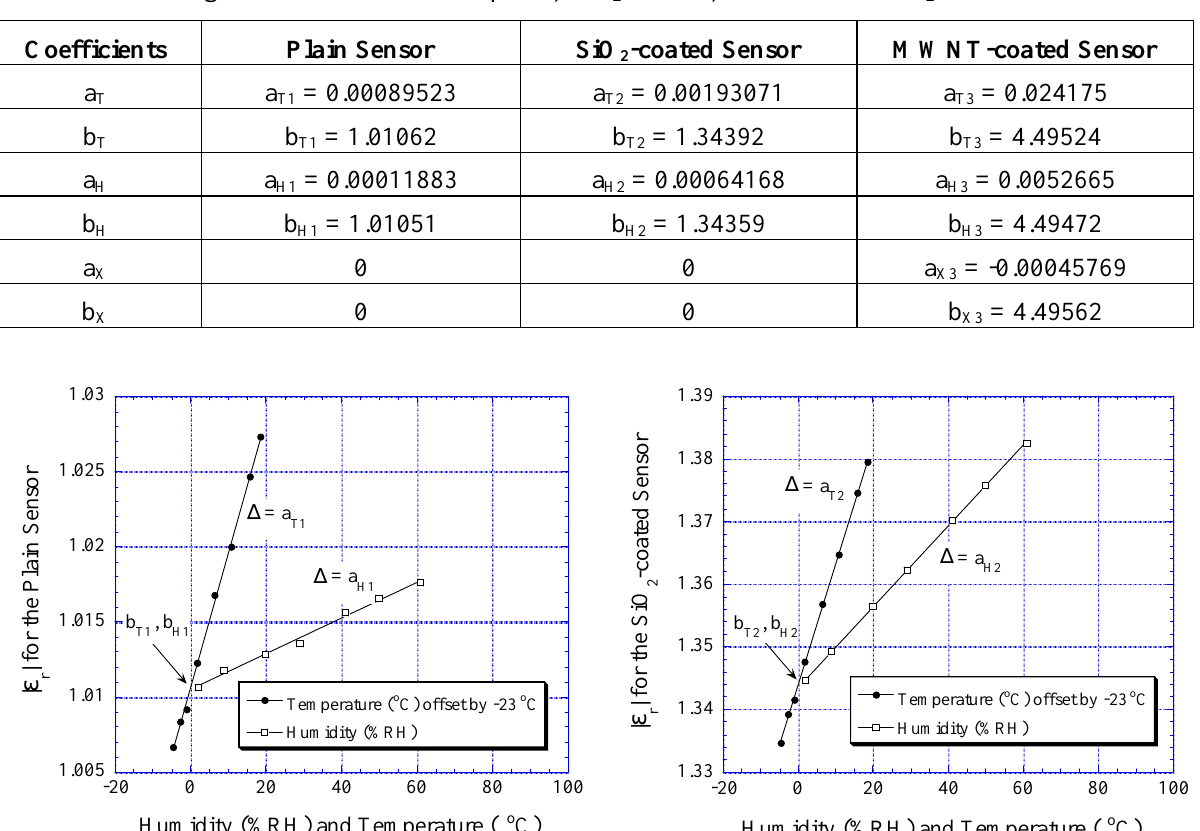
coated sensors. 2